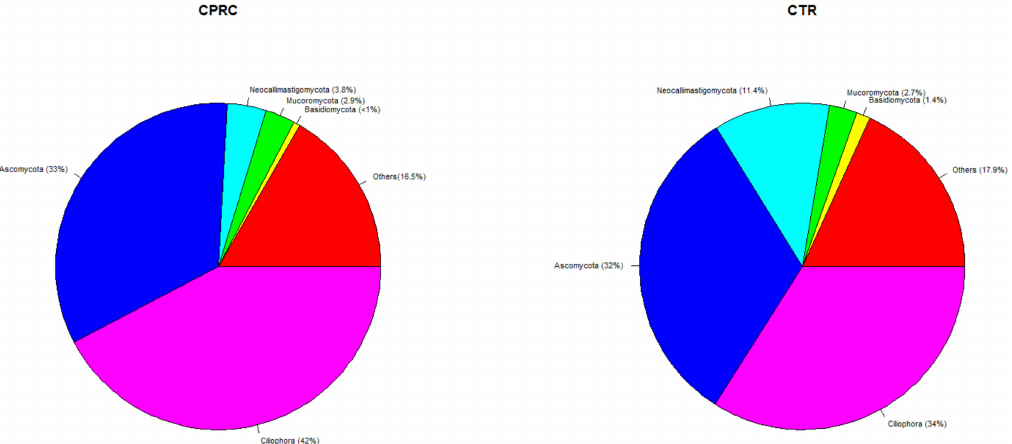
Figure 3. Mean relative abundances of Eukaryote phyla in the rumen samples of cows fed a concentrate with cold-pressed rapeseed cake (CPRC) or a control concentrate (CTR). “Others” include phyla with relative abundance <0.1% and phyla related to feed and the host (Charophyta, Chlorophyta, and Chordata).